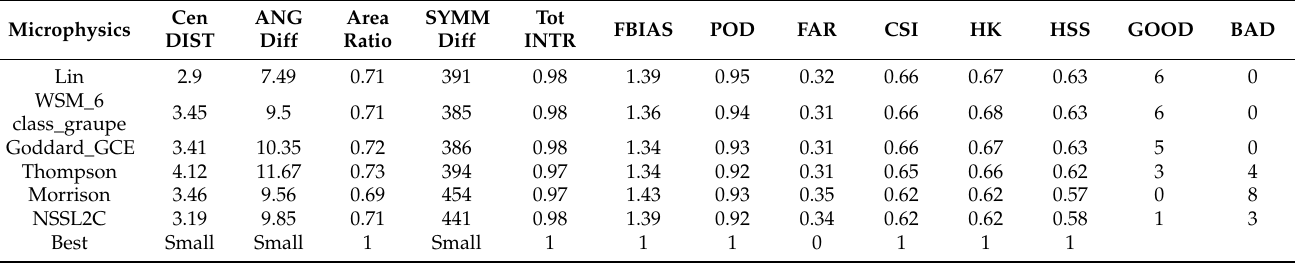
Table A3. Mode analysis using Era5 reanalysis data.